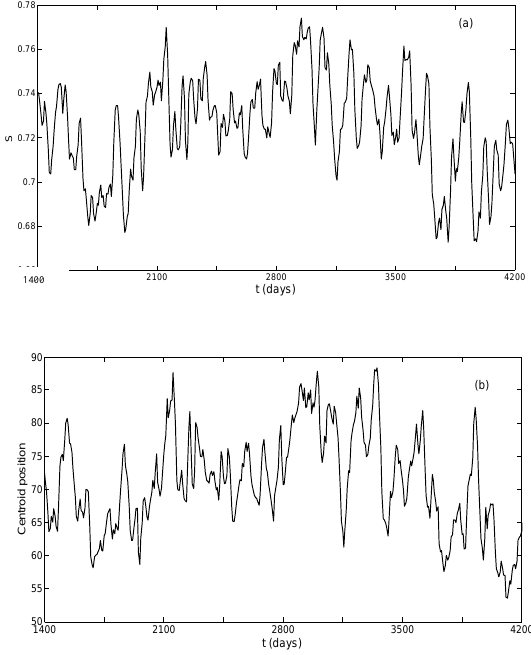
Figure 7. Evolution of spectral entropy and centroid, 10 Octo- ber 1992 to 23 May 2009. (a) Spectral entropy in non-dimensional units. (b) Spectral centroid in